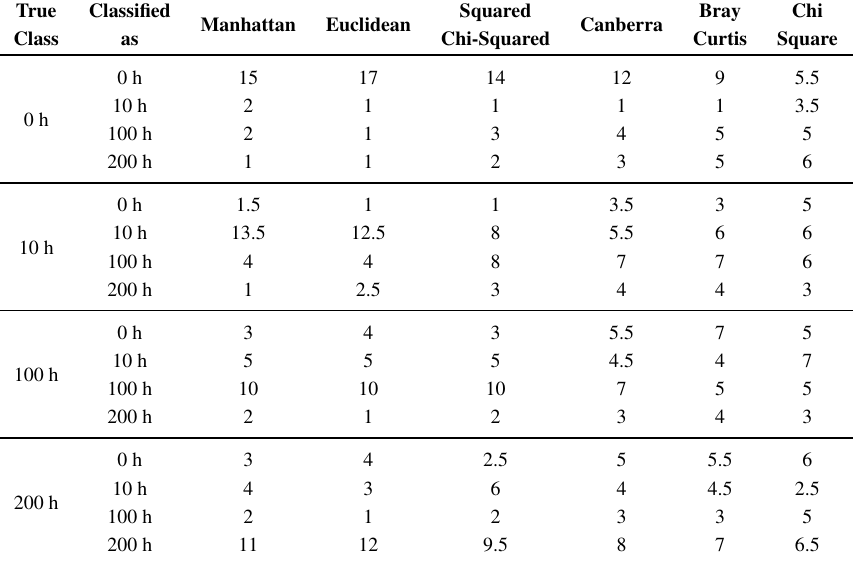
Table 11. Confusion matrix of the classification means for the 5-MHz frequency pulse echo signals at 950